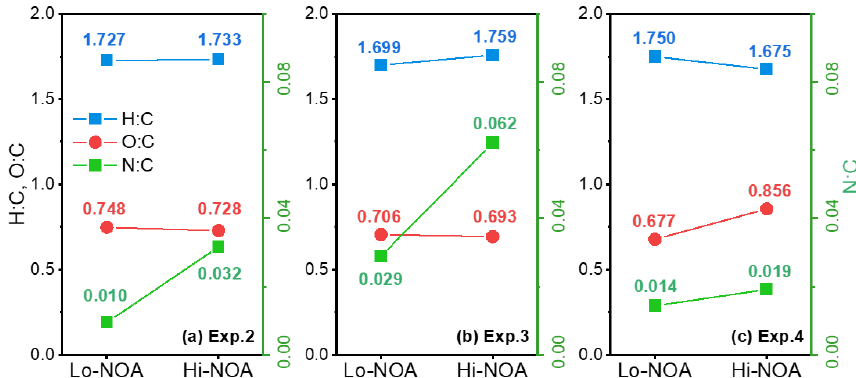
Figure 5. The H / C, O / C, and N / C values of Hi-NOA and Lo-NOA for each experiment. (a) Exp. 2 with 200ppb NH 3 , (b) Exp. 3 with 200ppb NH 3 and 62ppb NO 2 , and (c) Exp. 4 with 63ppb NO 2